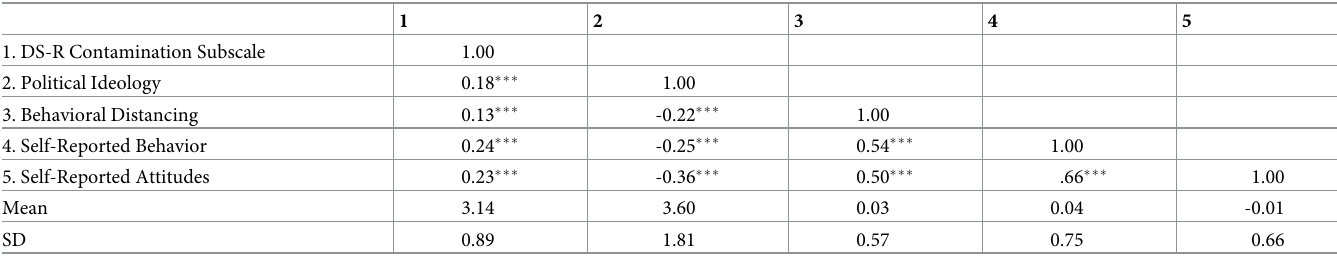
Table 2. Means, standard deviations, and correlations for all Study 2